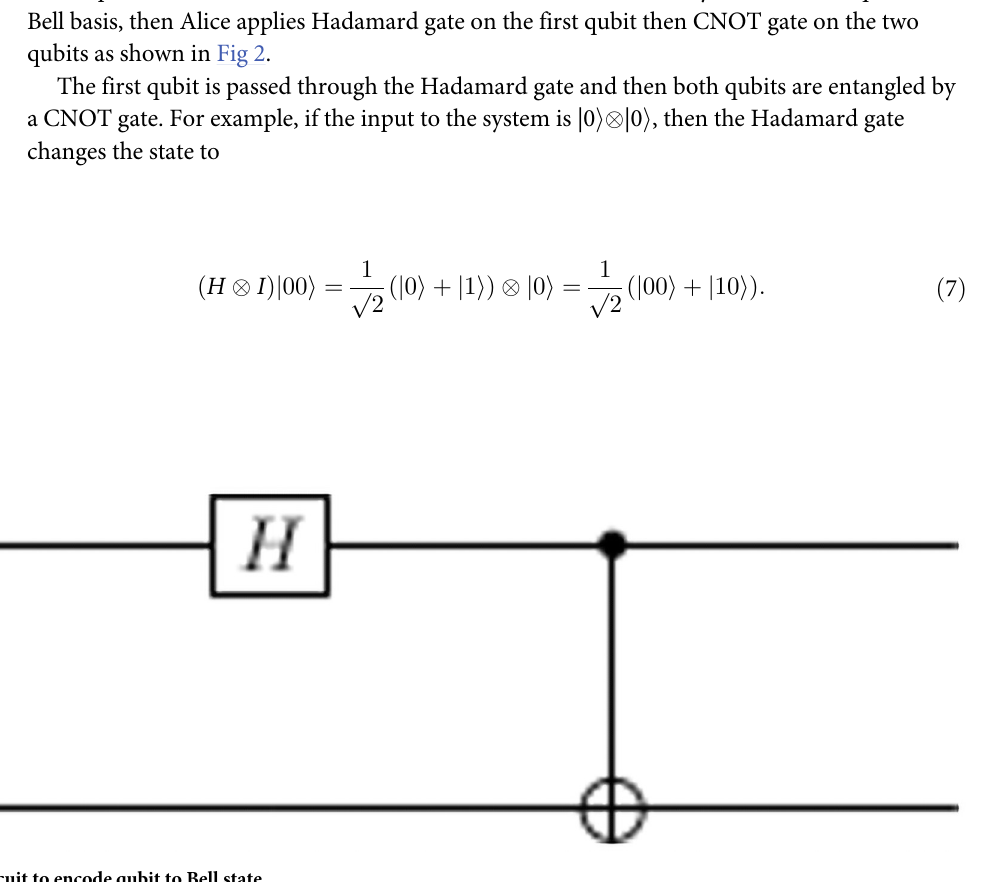
Fig 2. Circuit to encode qubit to Bell